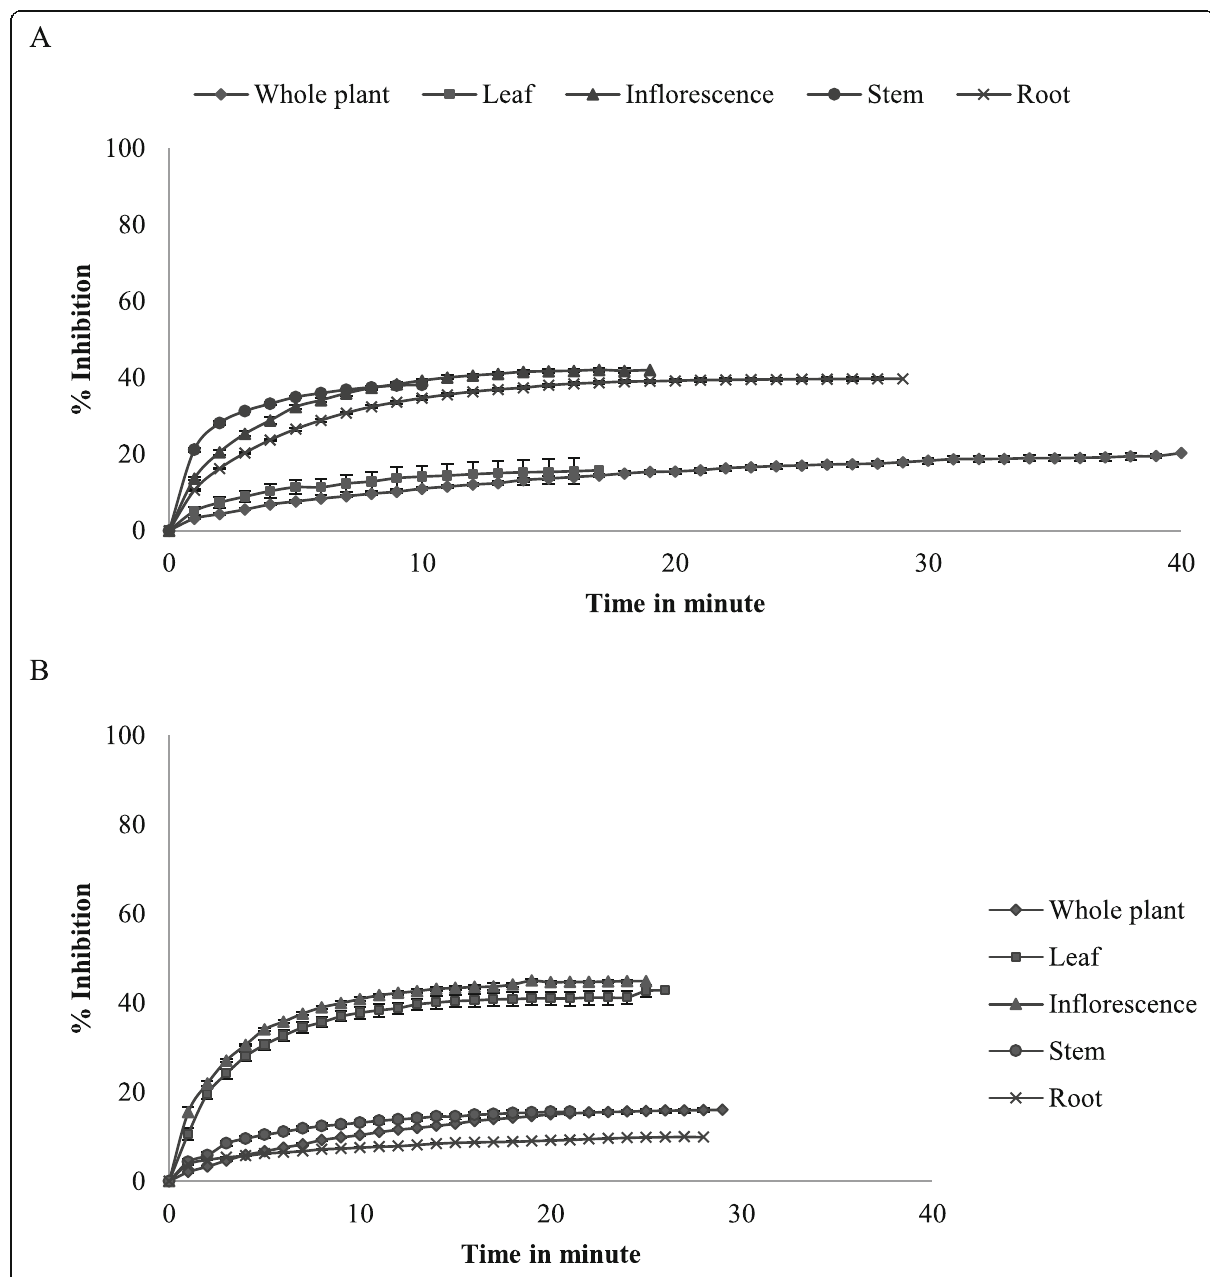
Fig. 2 Antioxidant activity of polar fraction of methanol ( a ) and aqueous extracts ( b ) of Sphaeranthusindicus by the DMPD assay over time and comparison with whole plant and